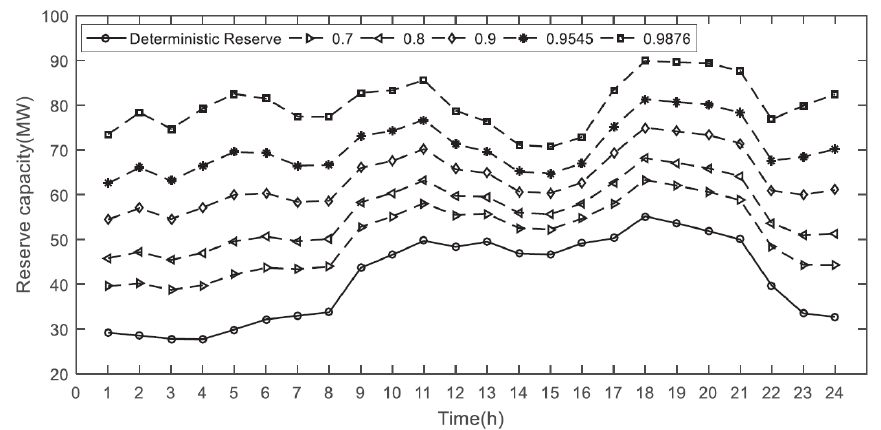
Figure 7. Reserve capacity under various confidence setups.